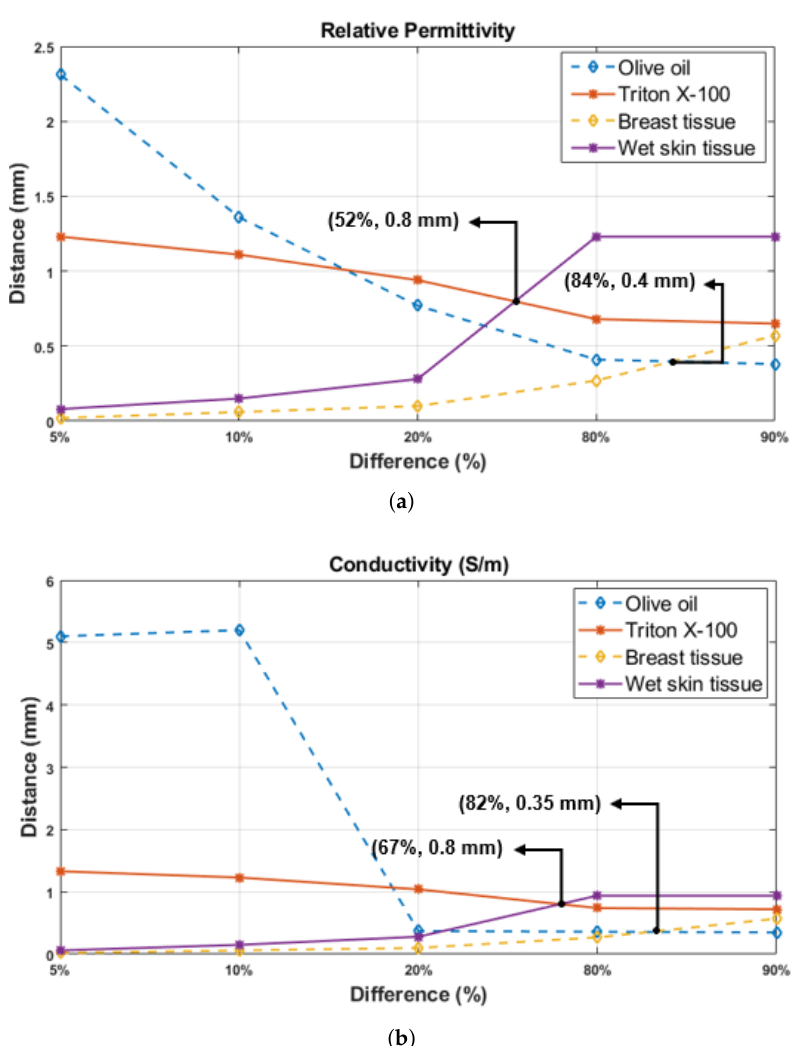
Figure 13. The probe tip distances from rat tissue layers (D n ) are shown as a function of five percentage change points in dielectric property of the materials used for double-layered configurations (olive oil, triton X-100, rat breast and wet skin tissue): ( a ) relative permittivity and ( b )